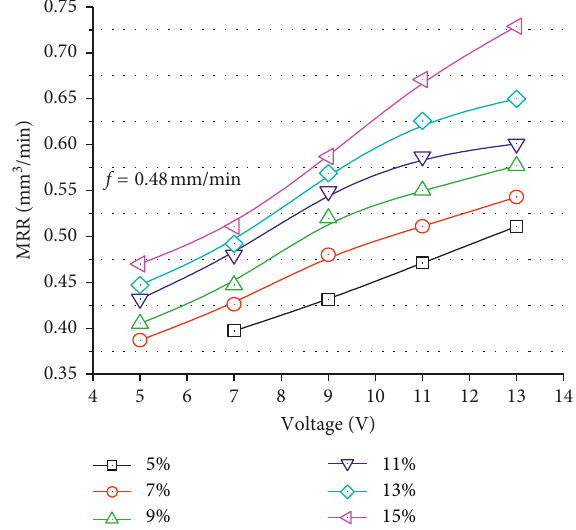
Figure 5: Variation curves of MRR with the